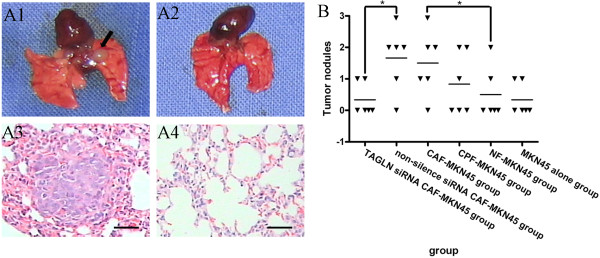
TAGLN enhances tumor metastasis through human tumor xenograft model in vivo. A: nude mice metastatic nodules in the lung. a1: lung metastatic nodules from tomur-bearing mouse. Arrow: metastatic nodule. a2: no metastatic nodule in lung. a3: H&E staining for lung metastatic nodule under bright-field microscope. Scale bars, 200 μm. a4: H&E staining for lung without metastatic nodule under bright-field microscope. Scale bars, 200 μm. B: quantification of nude mice lung metastatic nodules in various groups through tail intravenous injection. *, P < 0.05, by one-way analysis of variance (ANOVA).